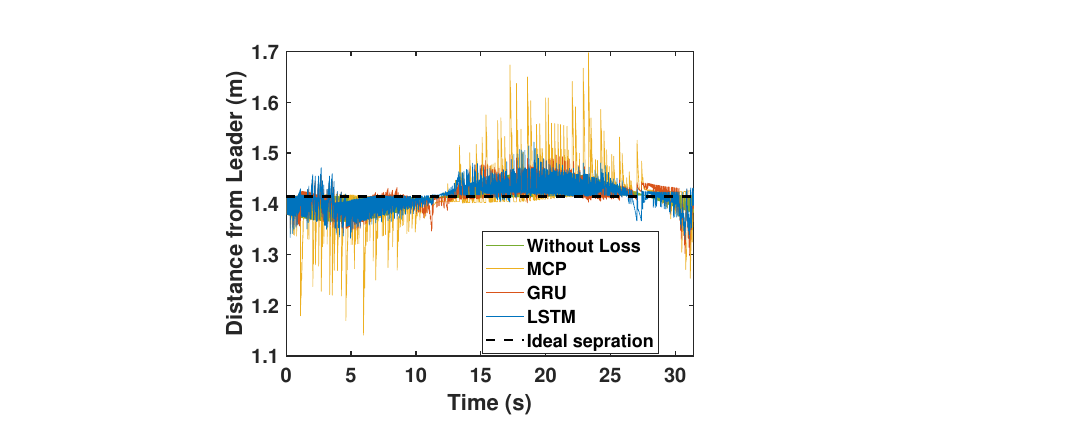
Figure 11. Distance of the follower from the leader for the circular trajectory (packet loss—50%). Table 3. RMSE of follower error for the circle path.